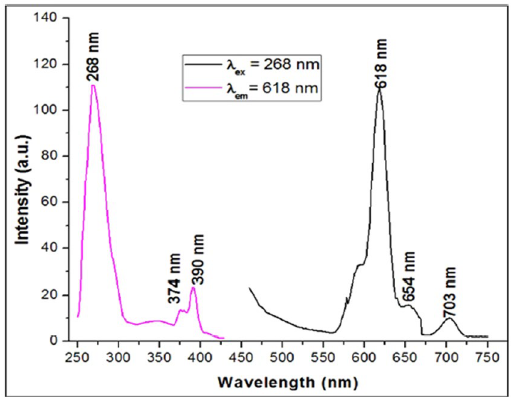
Figure 4. Excitation and Emission spectra of annealed SiO 2 :Eu nanoparticles. The peak at 268 nm is an absorption peak observed which when used as an excitation wavelength resulted in fluorescence emission at 618